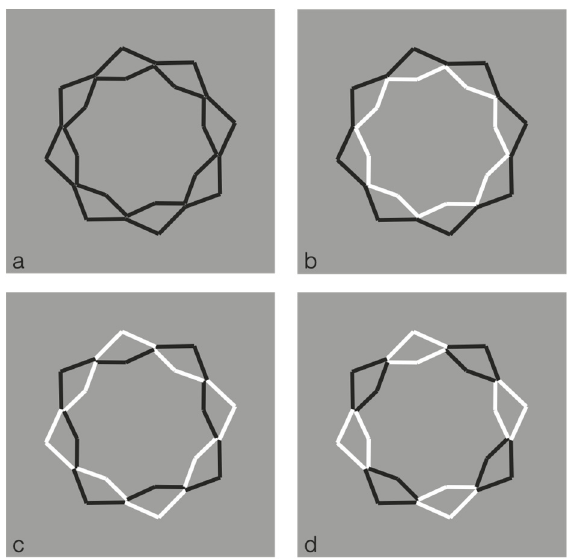
Figure 9. Different results on the basis of contrast polarity.